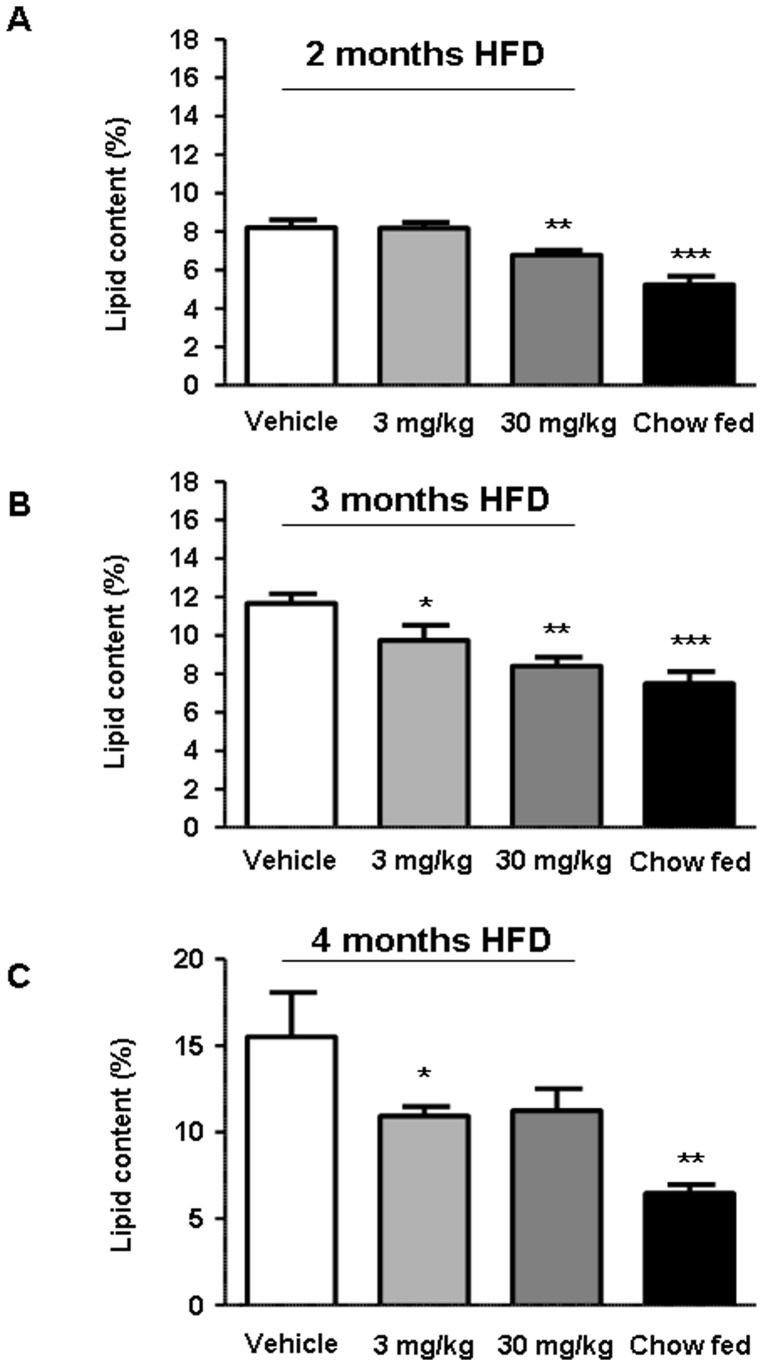
Effect of linagliptin treatment on liver lipid content in diet-induced obesity (DIO) mice.C57BL/6 mice were fed a high-fat diet (HFD) for either 2 months and treated with linagliptin (3 mg/kg/day or 30 mg/kg/day) or placebo for an additional 4 weeks (A), HFD for 3 months and treated with linagliptin (3 mg/kg/day or 30 mg/kg/day) or placebo for an additional 3 weeks (B), or HFD for over 4 months and treated with linagliptin (3 mg/kg/day or 30 mg/kg/day) or placebo for an additional 4 weeks (C). Liver lipid content was determined using magnetic resonance spectroscopy. Duration of HFD is displayed for the individual graphs. Values are given as mean ± SEM. *P<0.05; **P<0.01; ***P<0.001.